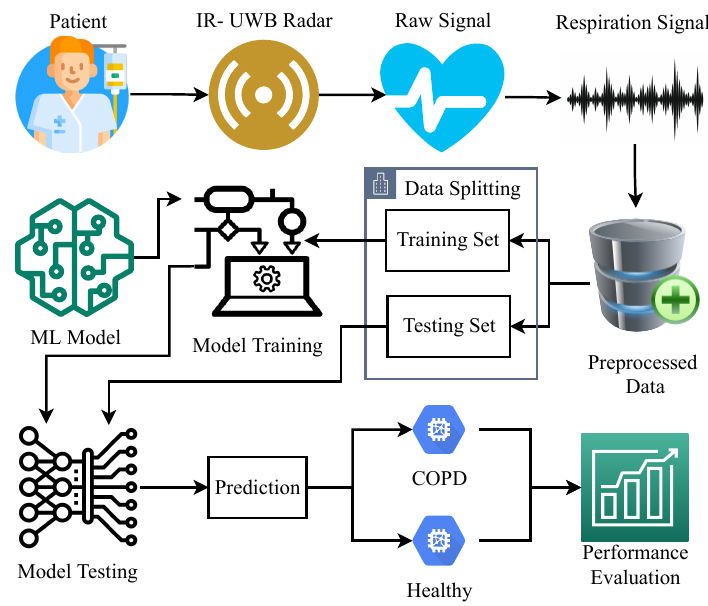
Figure 1. Architecture of the proposed